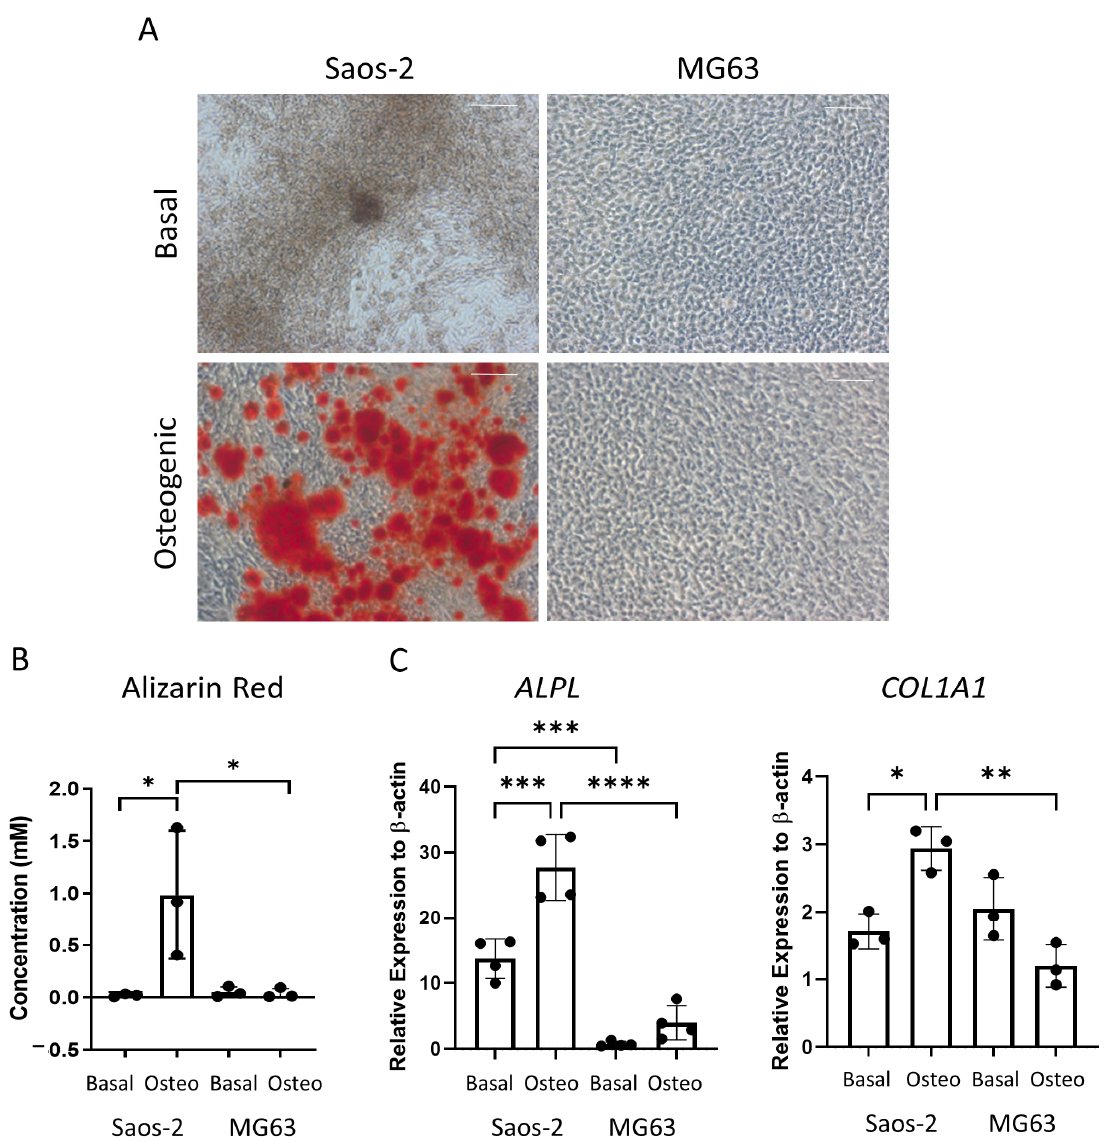
Figure 7. Osteogenic differentiation and mineralization of two osteosarcoma cell lines. Two osteosarcoma cell lines Saos-2 and MG63 were cultured in basal or osteogenic II and mineralization media for 28 days. ( A ) Alizarin red stains areas of mineralization red, demonstrating osteogenic differentiation. Scale bar = 100 µm. ( B ) Alizarin red quantification was performed on the osteosarcoma cell lines; absorbance was analyzed at 405 nm. ( C ) Gene expression analysis of ALPL and COL1A1 as a relative expression to β -Actin for osteosarcoma cell lines was performed by qPCR. n = 3–4, symbols refer to individual patient samples with three technical replicates. Results are presented as mean +/- SD. Significance determined using a one-way ANOVA, significance presented as * < 0.05, ** <0.01, *** < 0.001, **** < 0.0001.